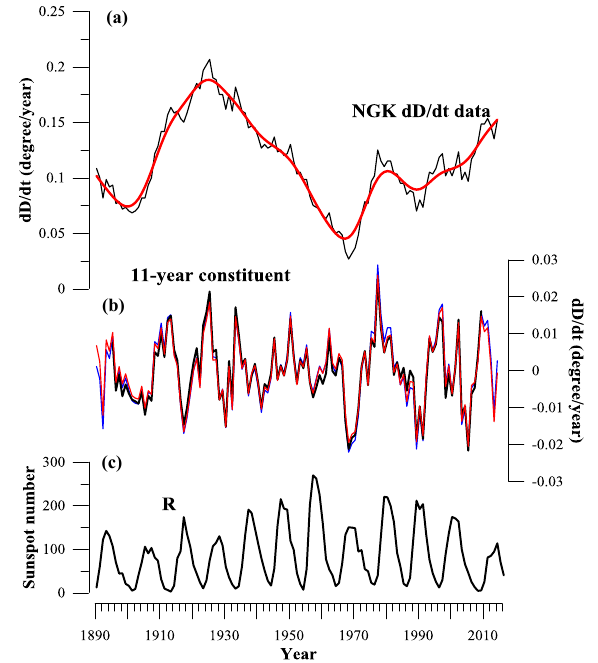
Figure 3. Constituents of the first time derivative of the declination at Niemegk Observatory. (a) First differences in annual means (thin black curve) and the trend from an HP filtering (thick red curve). (b) Cyclic constituent from an HP filtering (red), the 11-year signal from filtered first differences by an 11-year cutoff high-pass Butter- worth filtering (blue), and the 11-year signal obtained as a residual after the removal of an 11-year running average from the d D /d t time series (black). (c) The sunspot number time series ( R